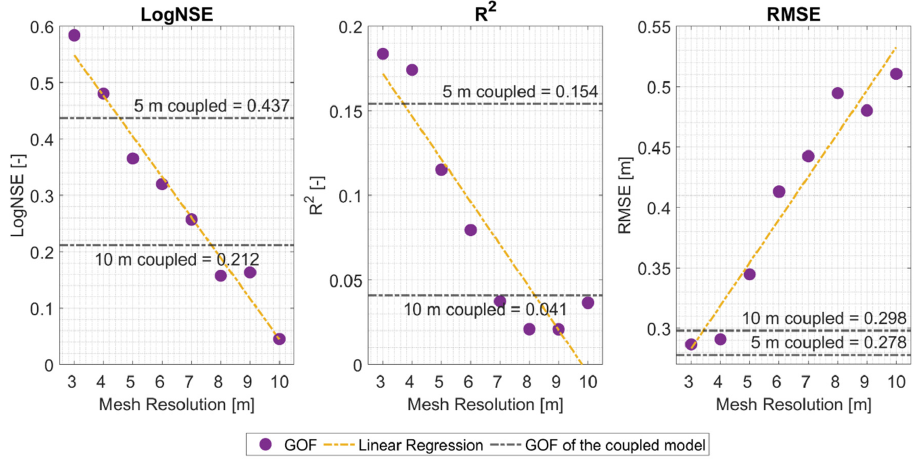
Figure 6. GOFs for different model resolutions and for the coupled models of 5 m and 10 m.